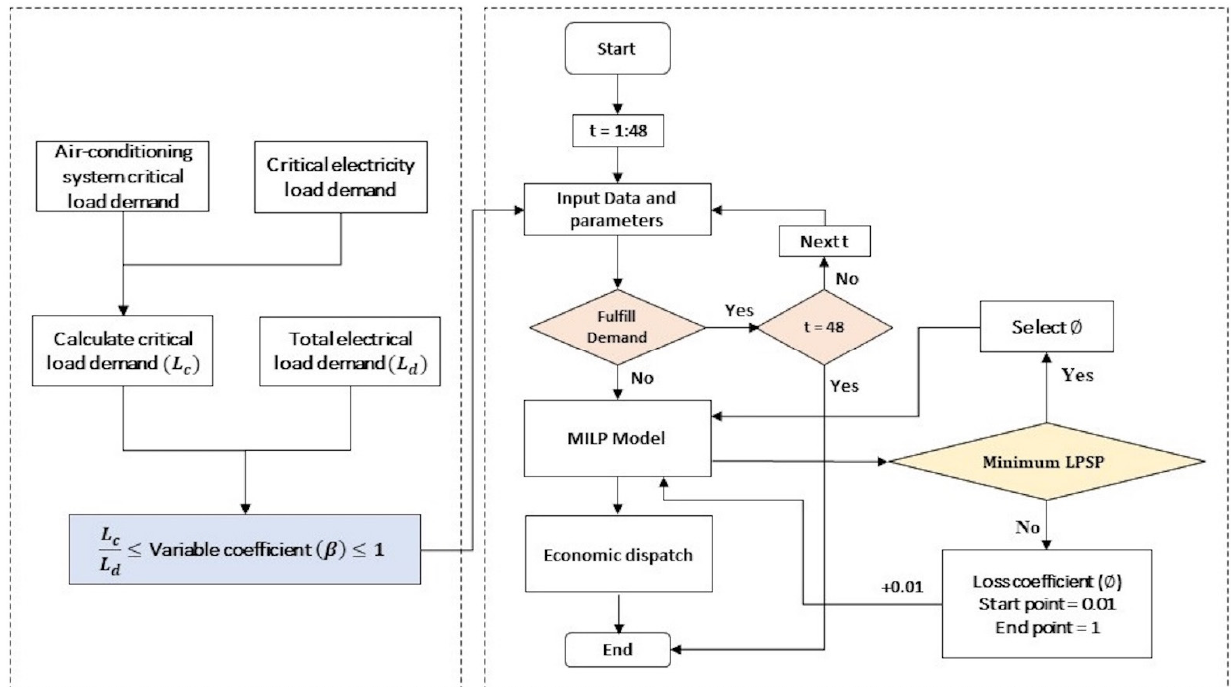
Figure 1. A schematic design of the optimization module.